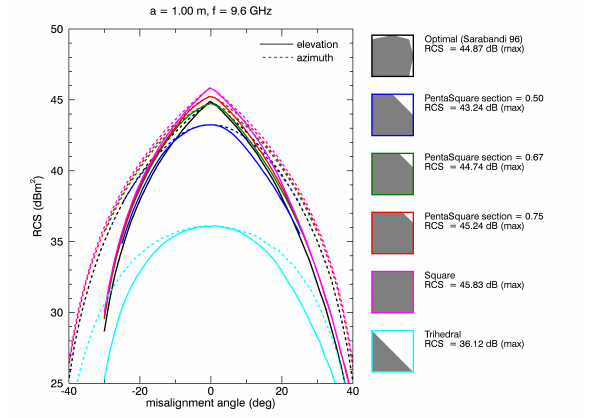
Figure 7. Loss of Radar Cross Section (RCS) due to misalignment for different shapes of CR.